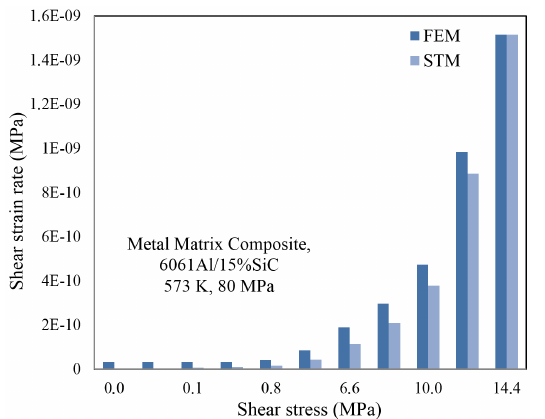
Figure 6. The relation between shear strain rate and shear stress at r = a + δ .